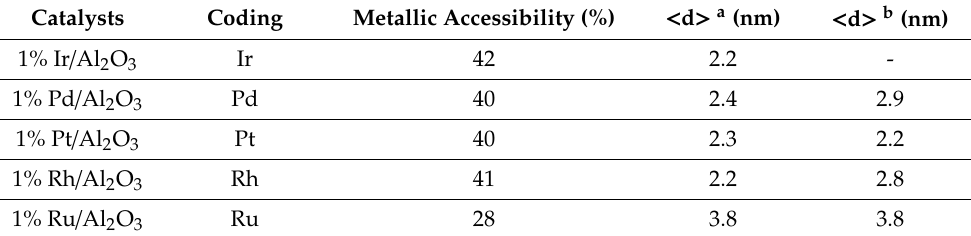
Table 3. Properties of catalysts: particles size and metallic accessibility.